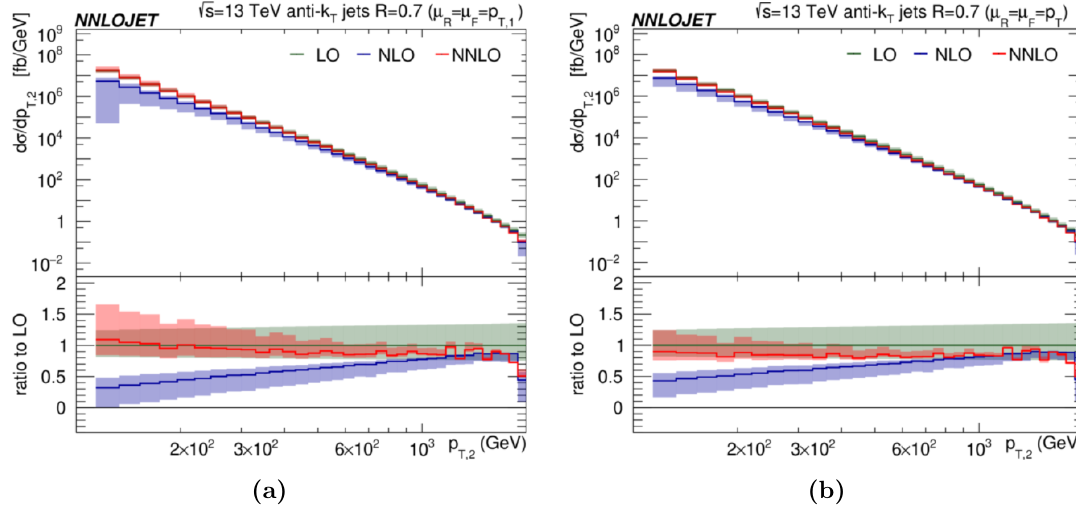
Figure 9 . Perturbative corrections to the transverse momentum distribution of the second jet at 13 TeV (CMS cuts, j y j < 4 : 7, R = 0 : 7), integrated over rapidity and normalised to the LO prediction. Central scale choice: (a) (cid:22) = p T ; 1 and (b) (cid:22) = p T . Shaded bands represent the theory uncertainty due to the variation of the factorization and renormalization scales.